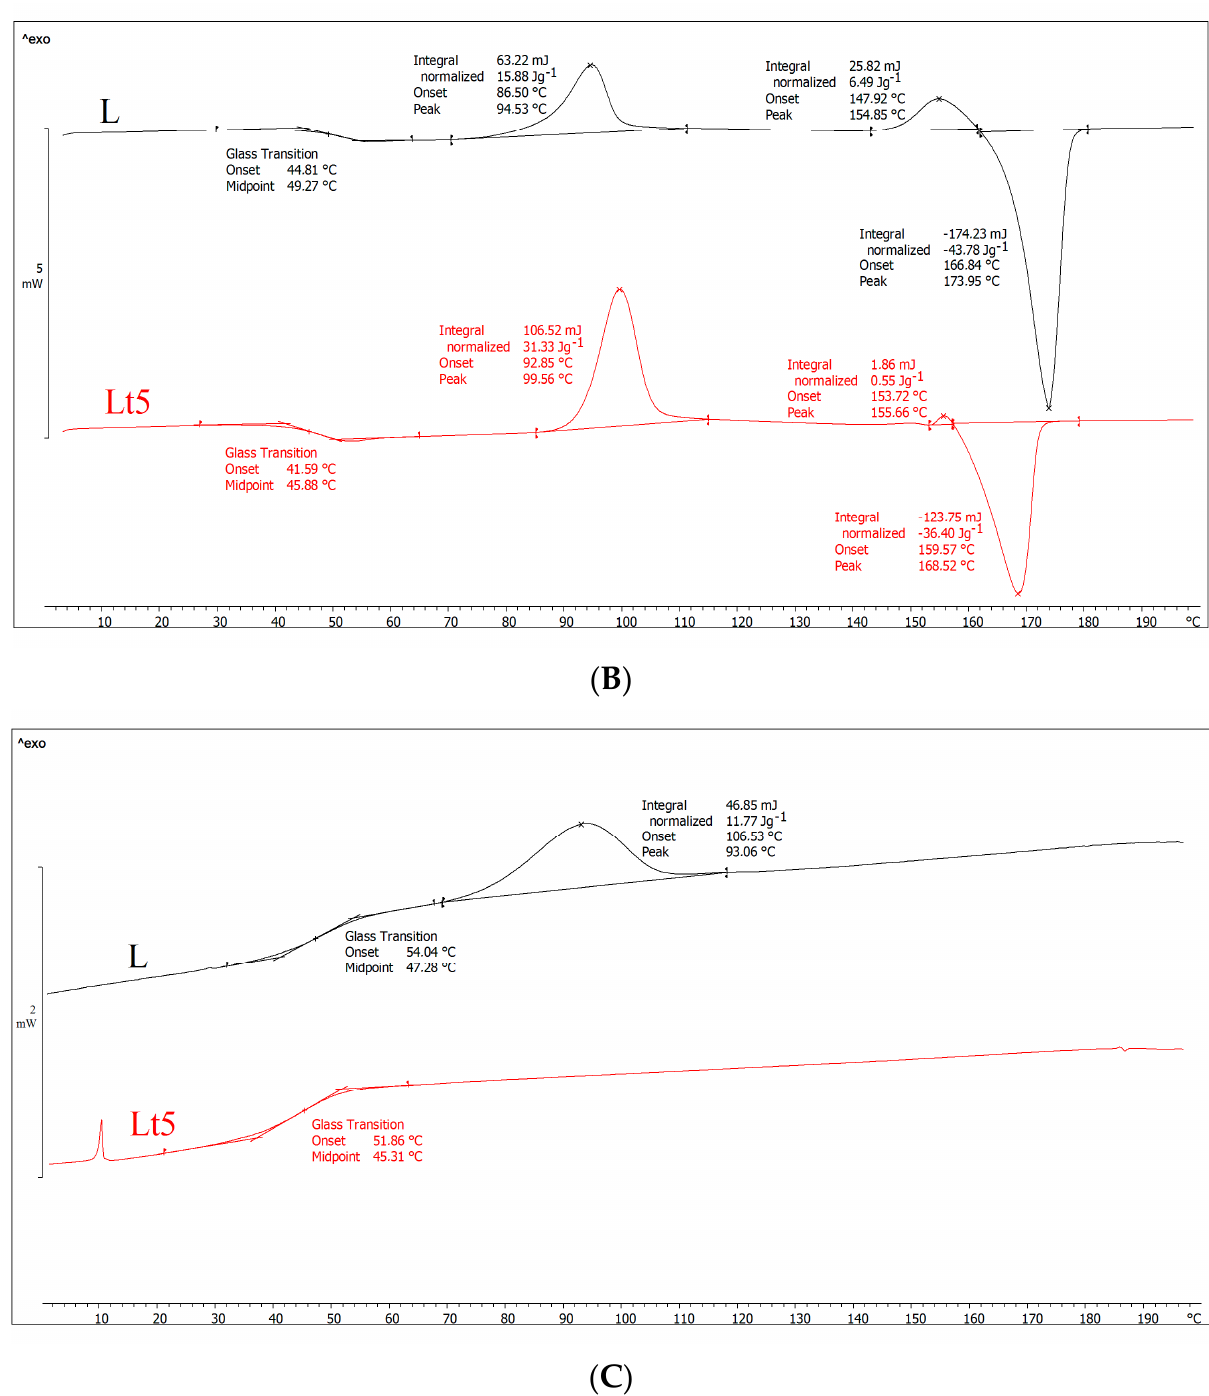
Figure 1. DSC results of plasticizer PLA (L) and plasticizer PLA with birch tar (Lt5) analysis. ( A ) First-run analysis (first heating), ( B ) second-gear analysis (second heating), ( C ) cooling analysis. Table 2. Thermal property test results determined by the DSC method; all symbols are explained in the text.